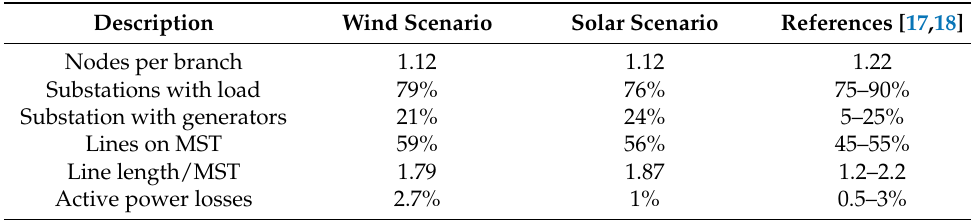
Table 1. Characteristics of the used synthetic transmission network topologies.